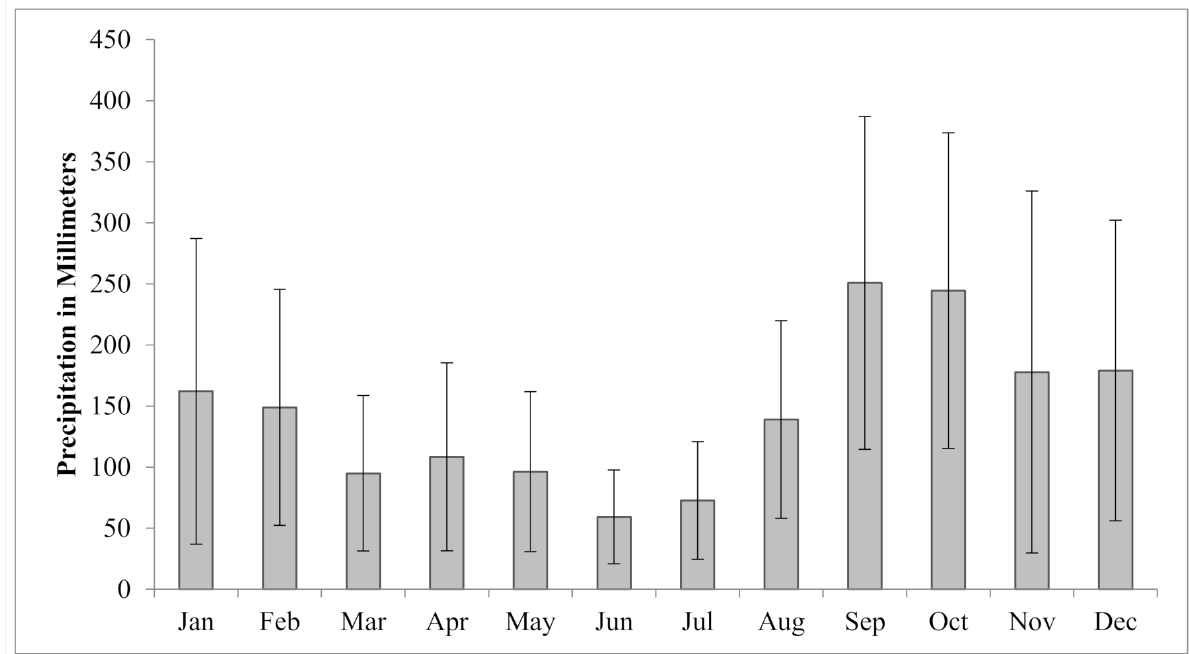
Figure 2. Average monthly precipitation for Seward Alaska, as measured at the Seward airport. The months of August– November periodically see heavy rains including remnants of tropical storms and typhoons which originate off the shores of Asia. Such storms have triggered both floods and slope failures throughout the area